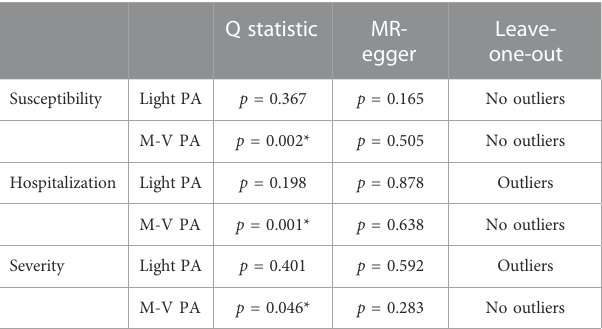
TABLE 2 Results of sensitively